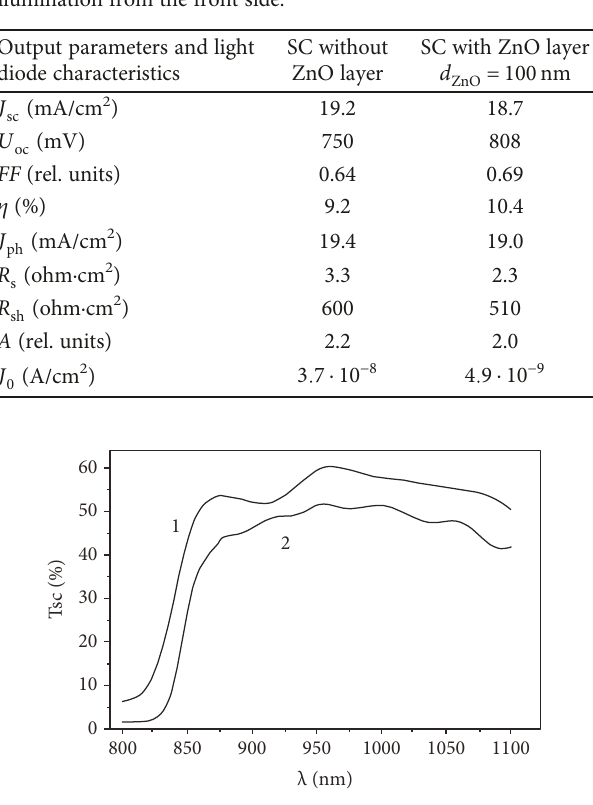
Figure 4: Transmittance spectra of polyimide/ITO/ZnO/CdS/ CdTe/Cu/ITO solar